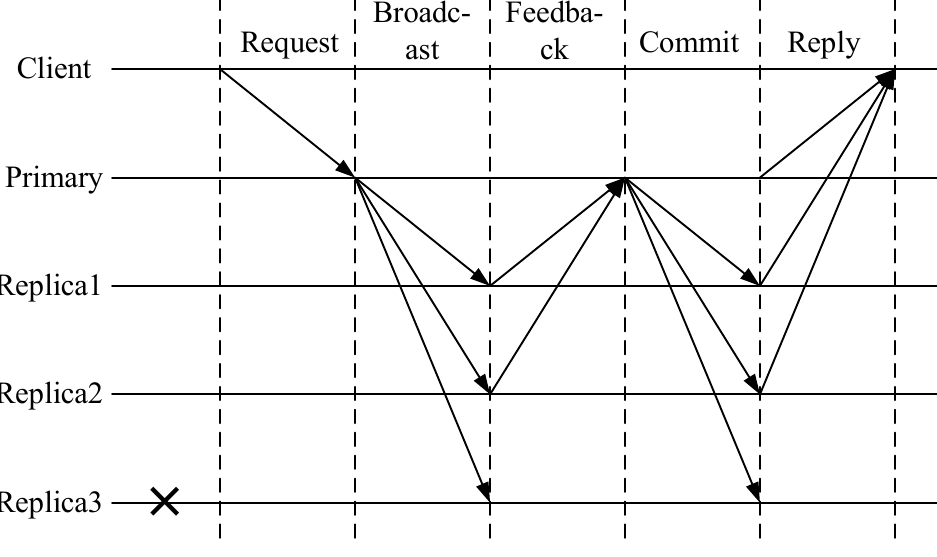
Figure 6. Simplified conformance protocol.